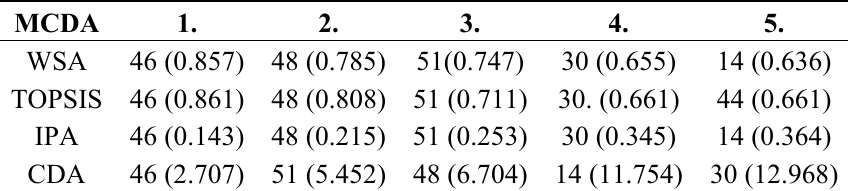
Table 9. Final MCDA scores for overall evaluation of above-the-ground floor